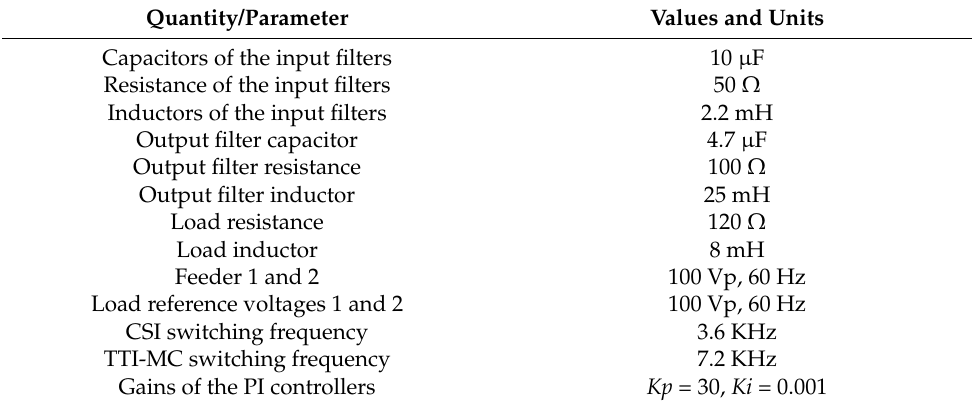
Table 1. TI-IDVR simulation